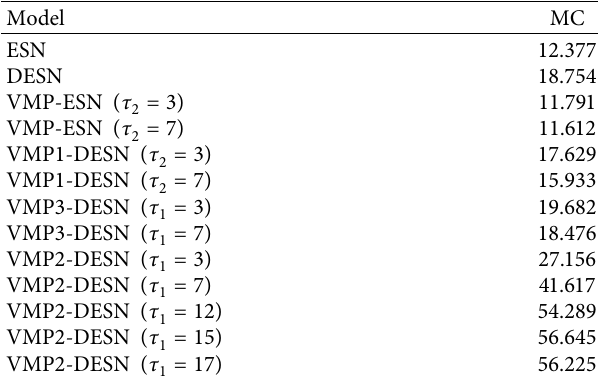
Figure 6: MC d in ESN, DESN, and d versus delay